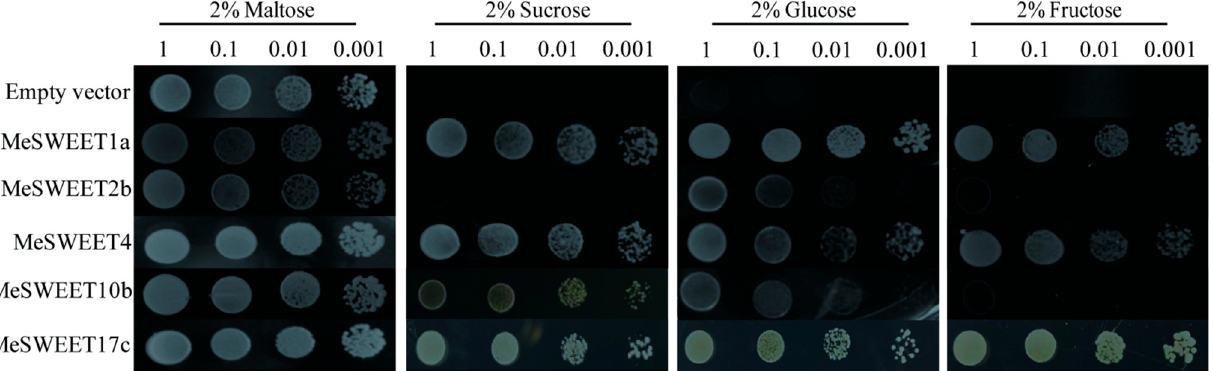
pressing an empty vector or a vector containing MeSWEET1a , MeSWEET2b , MeSWEET4 , MeSWEET10b , MeSWEET17c were diluted (10-fold) and cultured on selective synthetic deficient media without